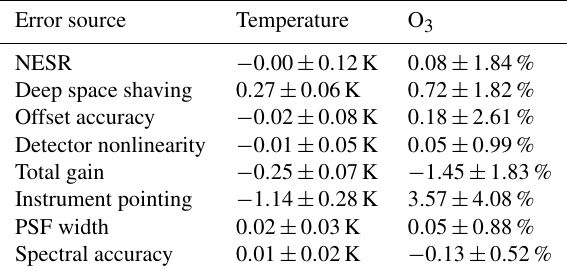
Table 5. Impacts of the specified error sources on two examples of level 2 products.